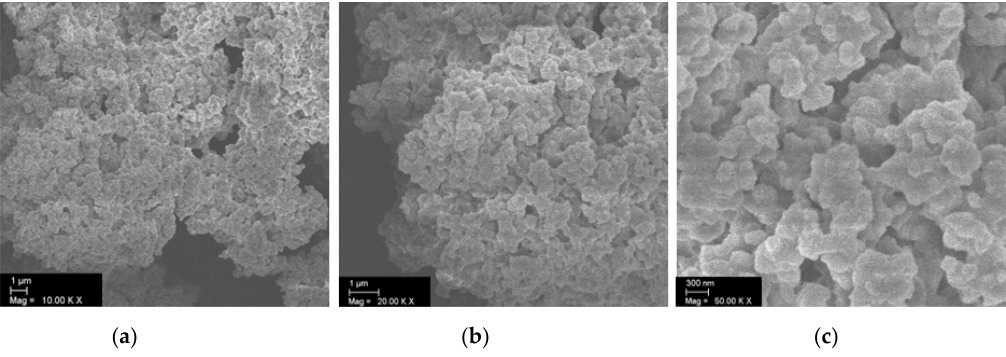
Figure 3. SEM image of the produced microclusters revealing pores of several microns. ( a ) 10,000×